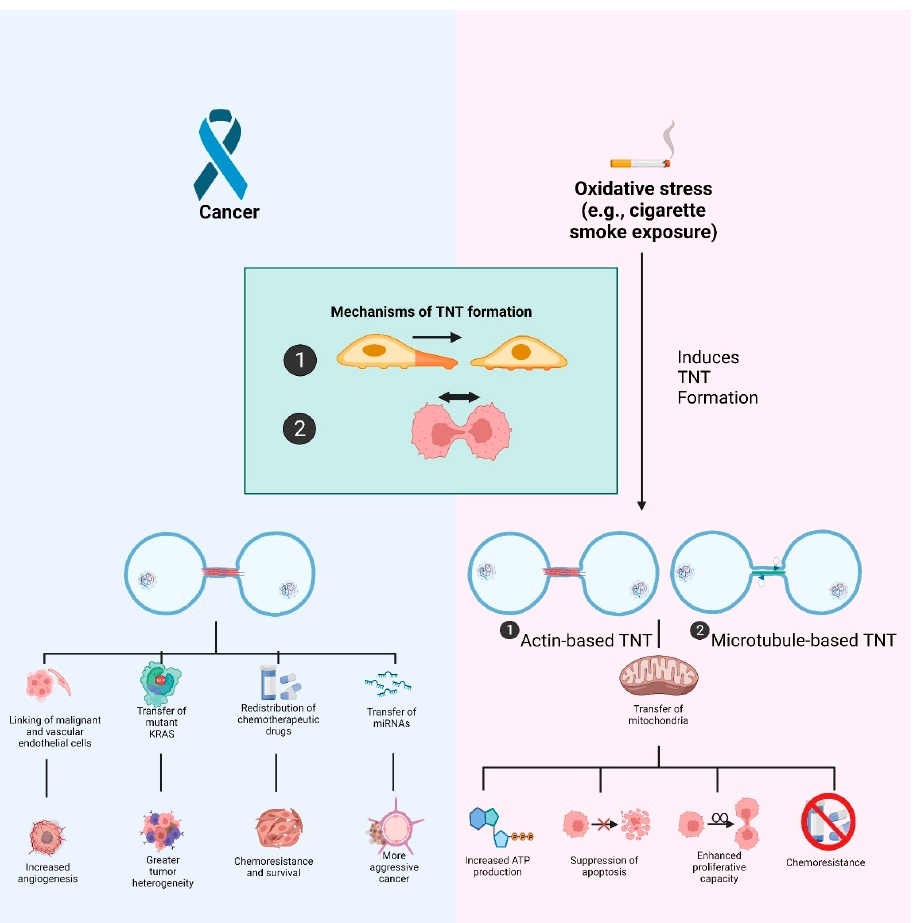
Figure 2. Overview of the role of tunneling nanotubes (TNT) in cancer as well as during oxidative stress. Both contexts involve two proposed mechanisms of TNT formation. In cancer, TNTs are able to transport different cargoes and form connections between cells or cell types to promote and spread cancer phenotypes. During oxidative stress, such as when cells are exposed to cigarette smoke, TNT formation is induced. In particular, the shuttling of mitochondria from healthy cells to cells experiencing a redox imbalance is able to rescue the struggling cells.